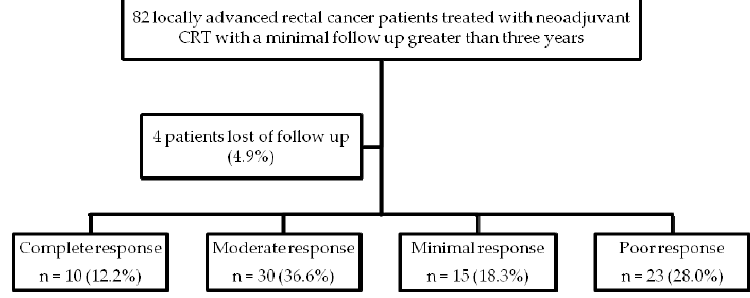
Figure 1. Patients flowchart through the study. CRT: chemoradiotherapy.